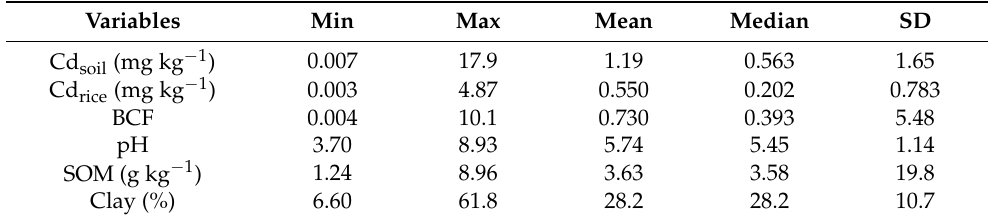
Table 2. Descriptive statistics on Cd concentrations in soils and rice grains as well as soil properties.